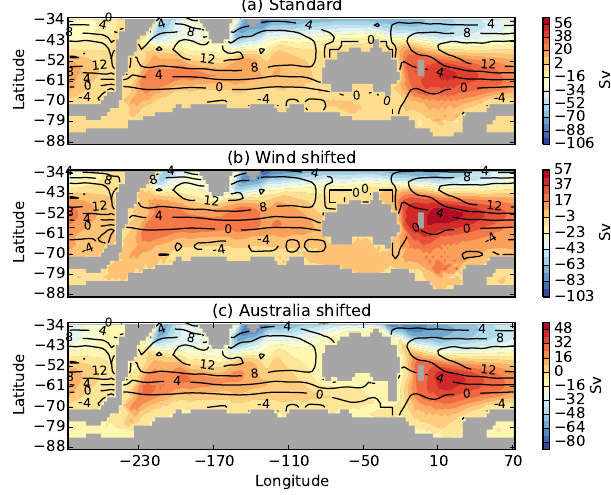
Figure 3. Ocean horizontal stream function (Sverdrup; 1Sv is 10 6 m 3 s − 1 ), with the zonal wind stress (10 6 Pa) overlaid. The Drake Passage is closed for (a) the standard simulation, (b) the Southern Hemisphere westerlies shifted north, and (c) Australia and part of the Antarctic coast shifted